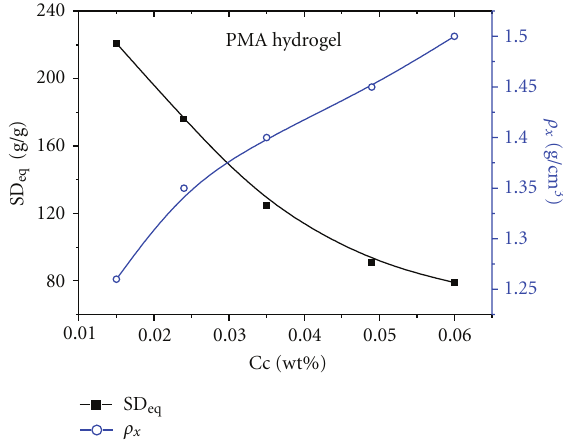
Figure 4: The e ff ect of crosslinker concentration on the macro- scopic properties of PMA xerogels.